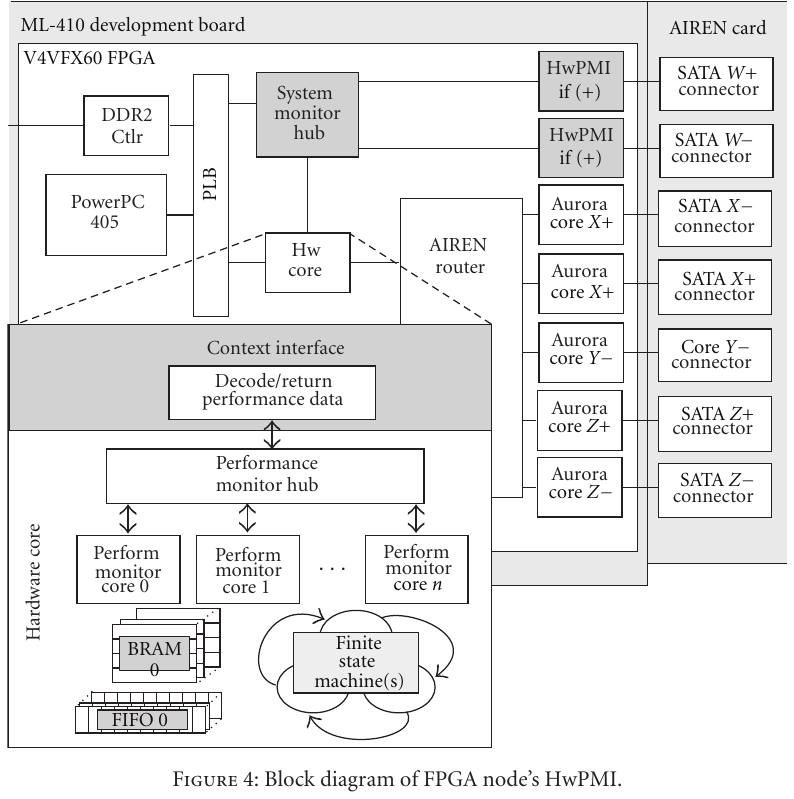
Figure 4: Block diagram of FPGA node’s HwPMI.